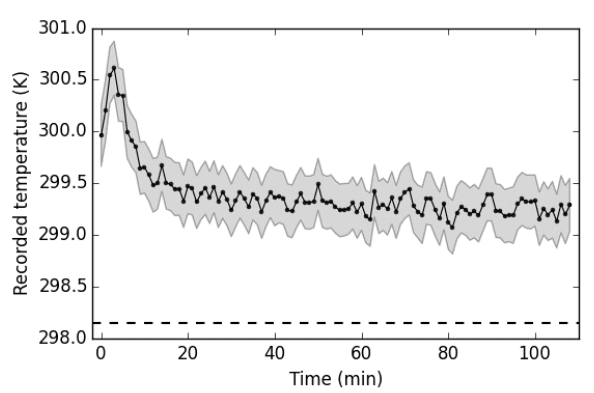
Figure 3. Mean image temperature of a blackbody at 298.15 K (dashed line), as recorded by a camera over time. Shaded areas represent one-sigma standard